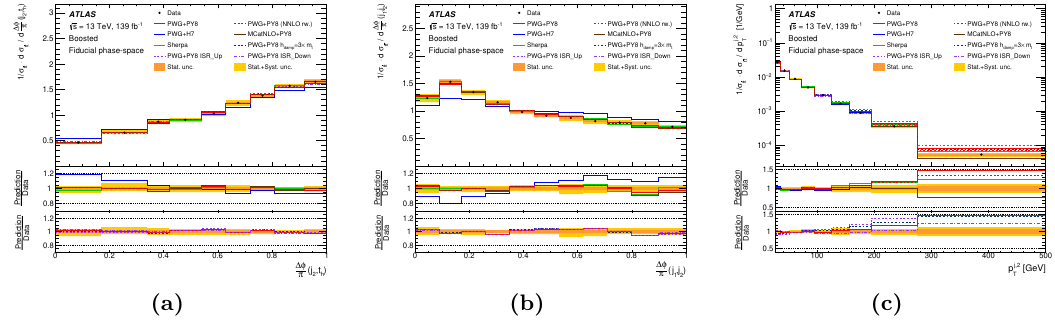
Figure 25. Normalised differential cross-section measurements for the observables related to jets produced in association with the t ¯ t system. The cross-section is shown as a function of (a) ∆ φ ( j (b) ∆ φ ( j ) and (c) p j, 2 , j 1 2 T